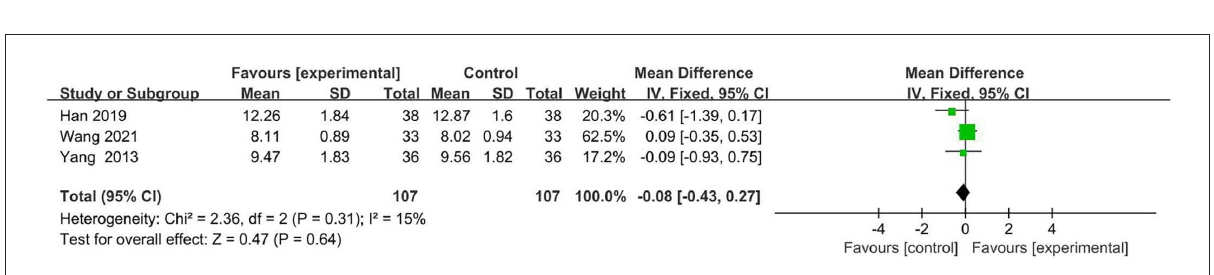
FIGURE7 Forest plot of GCS (Glasgow coma scale) comparing acupuncture vs. MT (medication therapy)